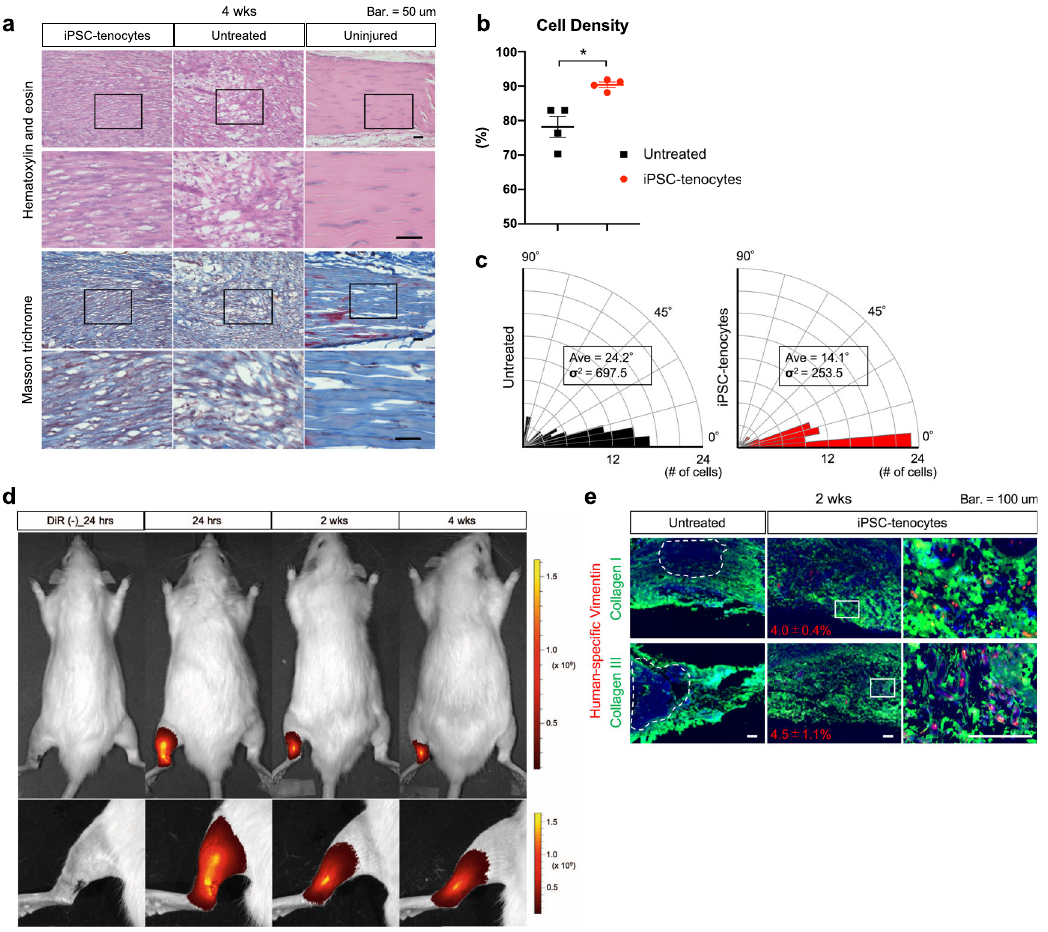
Fig. 5 Engrafted iPSC-tenocytes express tendon functional extracellular matrix at two weeks after transplantation. a Histological analyses of iPSC- tenocytes rats, untreated rats, and uninjured rats at 4 weeks after transplantation. Masson ’ s trichrome staining shows collagen fi ber (blue), cytoplasm (red), and nuclei (purple). Representative pictures of the transplanted area (left Achilles tendon) are shown. The boxed areas in the fi rst and third rows are shown with higher magni fi cation in the second and fourth rows, respectively. Scale bars: 50 μ m. b Density of cell fi bers stained with eosin. Image J was used for calculation ( n = 4: biologically independent samples). Data represent mean ± SE. * P < 0.05, two-tailed Welch ’ s t-test. c Rose diagrams of the regenerated fi ber angle from the horizontal line. The angle of hematoxylin-positive cells was analyzed using Image J, and the average and variance were calculated. d Biodistribution of DiR-labeled iPSC-tenocytes at 24 h and 2 and 4 weeks after transplantation. e Immunohistochemistry of regenerated Achilles tendons harvested from iPSC-tenocytes rats and untreated rats at 2 weeks after transplantation. Tissues were stained with anti-human speci fi c vimentin (red), type I collagen (green), and type III collagen (green) antibodies and co-stained with DAPI (blue). Representative images are shown. Dotted lines indicate non-regenerative regions. Positive rates of anti-human speci fi c vimentin to DAPI were calculated using Image J ( n = 4: biologically independent samples). Data represent mean ± SE. Scale bars: 100 μ m. Source data are provided as a Source Data fi